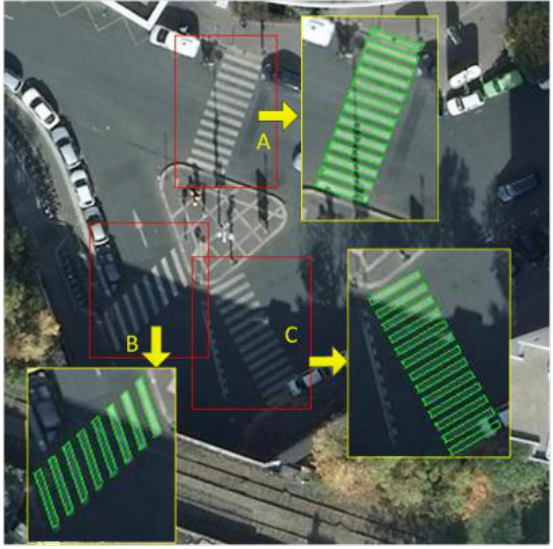
Figure 19. The geometric shape reconstruction of zebra crossing within shadows.